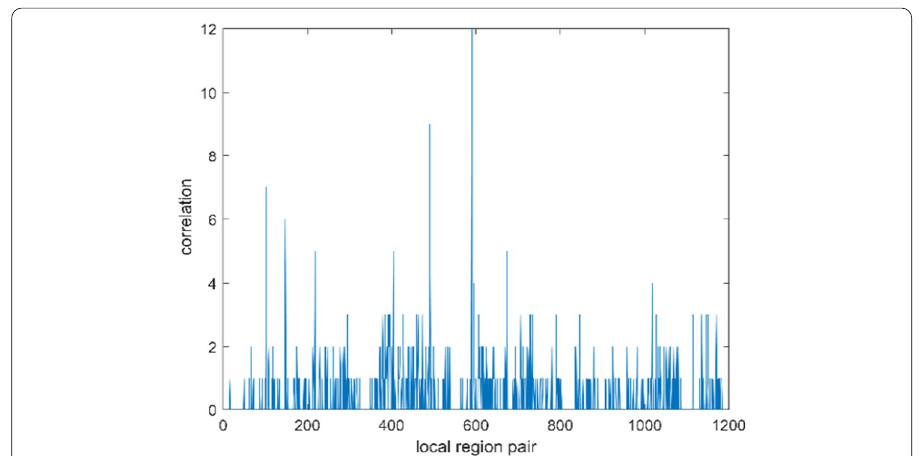
Fig. 4 Correlation distribution map